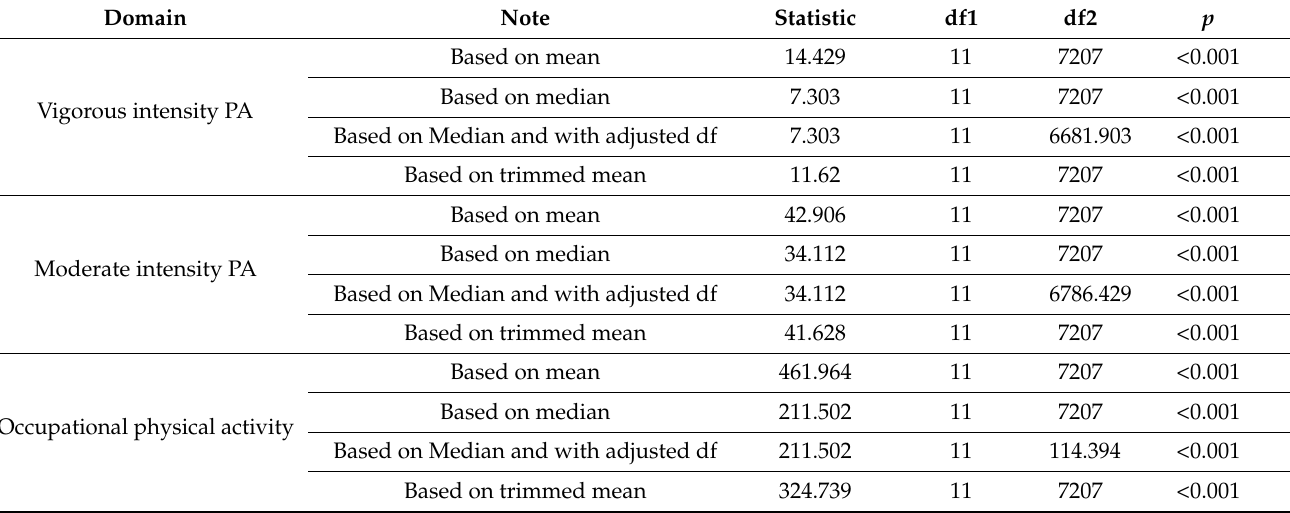
Table A3. Levene’s test of equality of error variances.